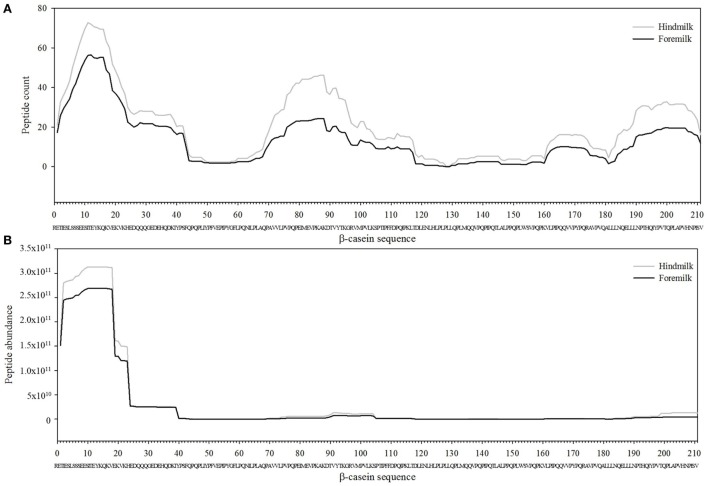
Count (A) and abundance (B) of peptides identified in breast milk mapped on the sequence of β-casein.